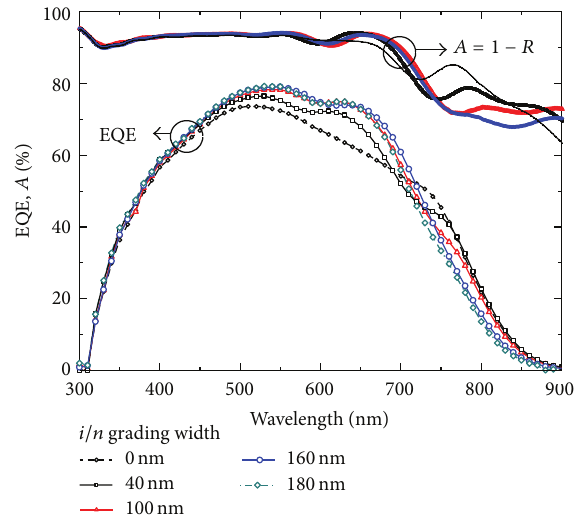
Figure5:Absorptance( 𝐴 )andEQEofa-Si 1− cellsasafunctionofthe i/n gradingwidth.The i/n gradingwidthwas changed from 0 to 180nm meanwhile keeping the p/i grading width and the total thickness of the absorber at 15 and 230 nm,